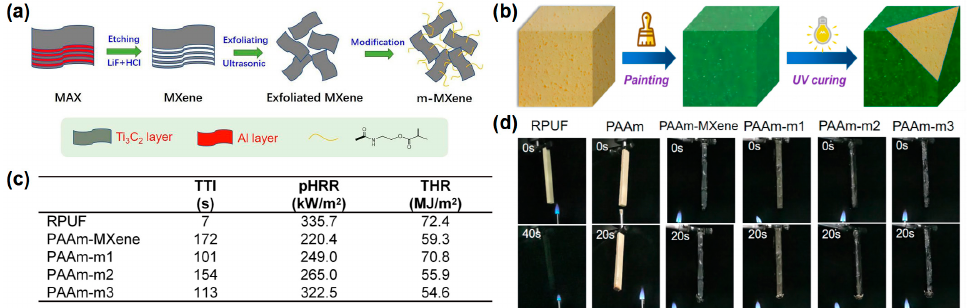
Figure 2. ( a ) Schematic diagram of preparation route of m-MXene nanosheets; ( b ) UV curing process of coated RPUF, ( c ) TTI, pHRR, and THR data of samples in cone test; ( d ) video screenshot of pure RPUF and coated RPUF samples during UL-94 testing [30].